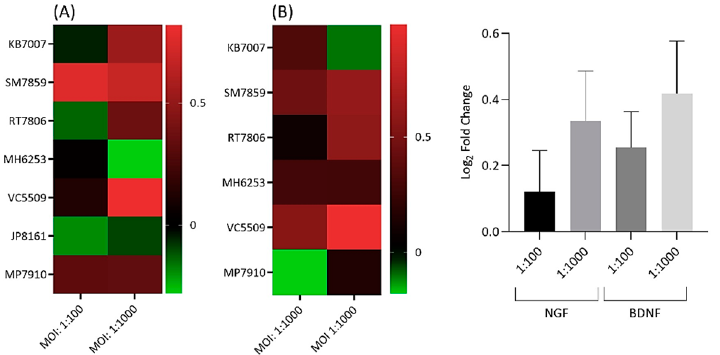
Figure 8. Heatmap and bar chart of log 2 fold gene expression changes for nerve growth factor (NGF) ( A ) and brain-derived neurotrophic factor (BDNF) ( B ) in C. acnes -infected NP disc cells (MOIs = 1:100 and 1:1000). Heatmap values are individual changes (3 × biological replicates), while the bar chart represents average donor changes. NGF is based on seven cell donors and BDNF on six. Side bars represent the log 2 fold-change scale.